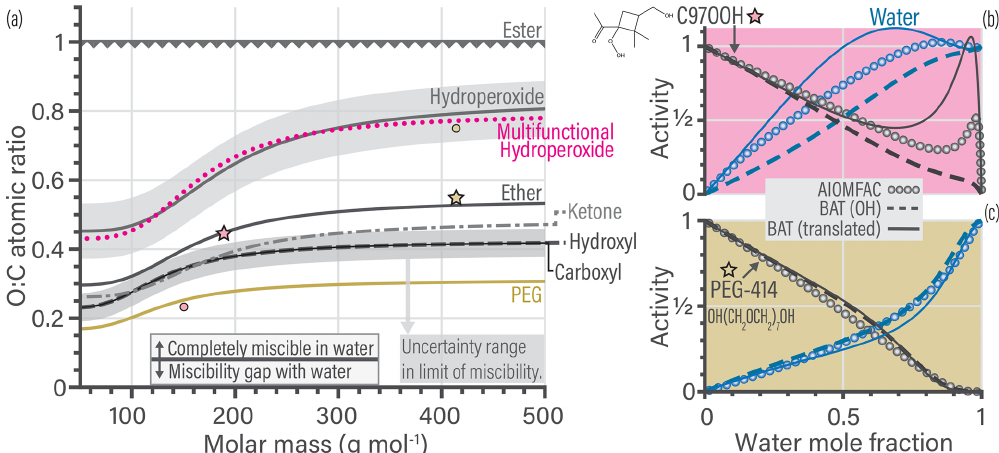
Figure 4. (a) Predicted limit-of-miscibility lines for different types of oxygen-bearing functional groups, generated from a translation of the hydroxyl-based BAT model (see text and Sect. S2.4). Above the line, the organic is completely miscible in water, and below the line it has a miscibility gap with water. The uncertainty range (gray shaded region) for the hydroxyl-based limit is the average difference in O : C for the seven molecules that did not conform to the hydroxyl-based miscibility limit line. We propagated the uncertainty range from the hydroxyl- based to the hydroperoxide-based line. The dotted pink line is the translation used in (b) , and the gold line is the translation used in (c) . (b, c) Comparison of the data generated from AIOMFAC (circles), the BAT model with hydroxyl-based (OH) parameters (dashed lines) and the BAT model with translated input values for O : C and M org (solid lines). The change in the model input parameters are shown in (a) as stars for the original value (used in the BAT (OH) line) and circles indicating the translated values used as input for the BAT (translated) calculation. Water activity is in blue and organic activity in black. The comparison for a multifunctional hydroperoxide (C97OOH) is shown in (b) . The BAT (translated) curve represents a more hydrophobic organic than the BAT (OH) curve and it shows an a w > 1 range, which is qualitatively consistent with AIOMFAC. The PEG-414 comparison is shown in (c) and highlights that the BAT (OH) model already captures most of the PEG behavior. The BAT (translated) curve for PEG-414 shows an improved treatment at x w > 0 . 85. All cases for T = 298 .